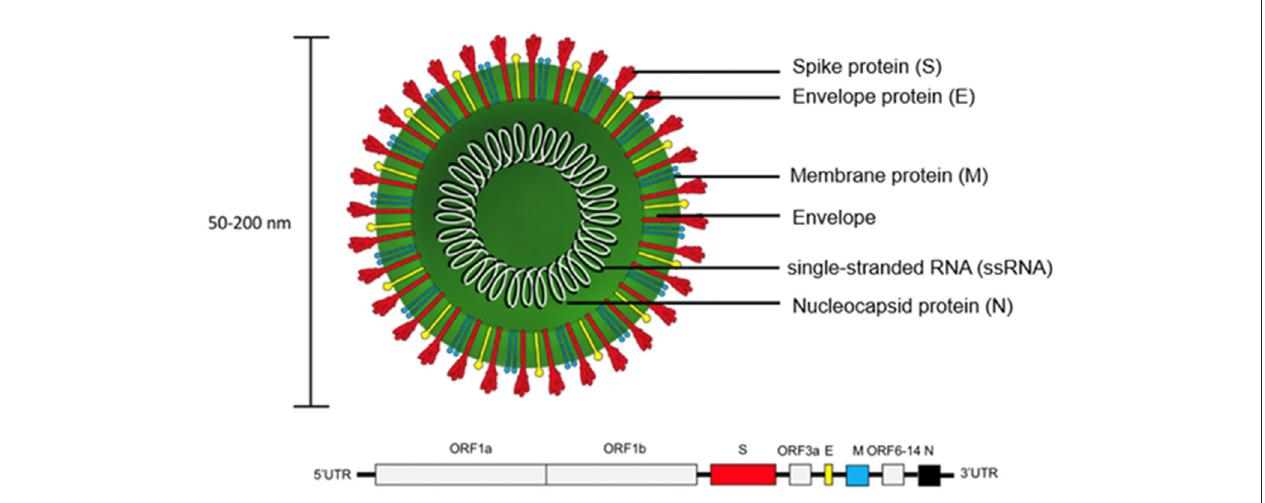
FIGURE 2 | Structure of SARS-CoV-2 virion and genome. The trimeric spike protein (S) is required for docking to the hACE2 receptor. S protein is targeted by antibody-based therapies and is used as the immunogen for vaccine candidates. The single-stranded RNA (ssRNA) genome is bound to the Nucleocapsid phosphoprotein (N) which facilitates transcription after virus entry into host cells. The large viral genome (29.9kb) is arranged as open reading frames (ORF) encoding for about 27 non-structural proteins (e.g., replicase, protease) and the four structural proteins (S, E, M, N).